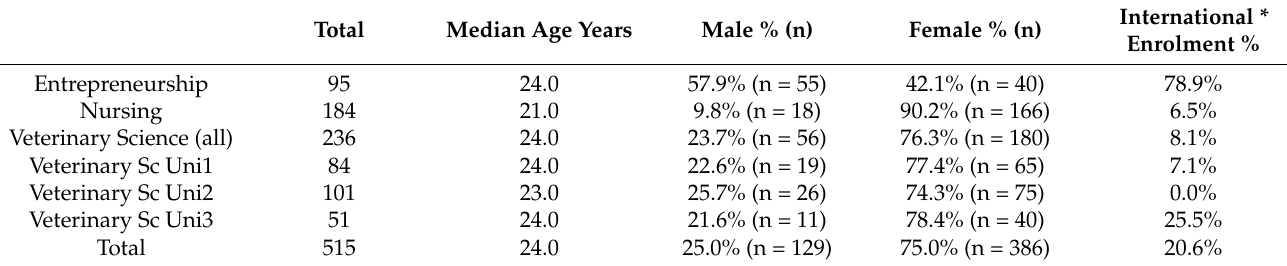
Table 1. Demographic profile of respondents after data hygiene (n =